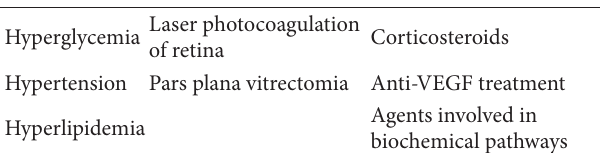
Table 1: Treatment of diabetic